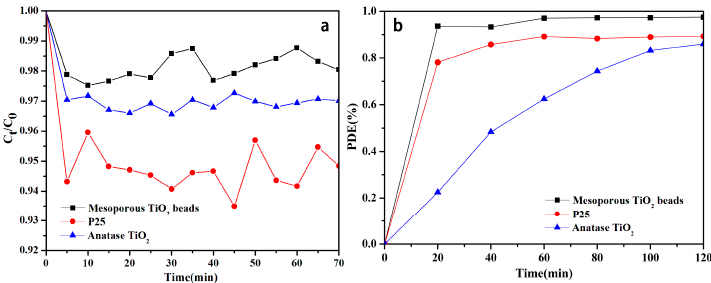
Figure 5. Adsorption and photocatalysis of methylene blue (MB) by mesoporous spherical TiO 2 and P25 TiO 2 (C 0 is the initial concentration of the MB solution, and C t is the concentration of that at different time intervals during the adsorption).